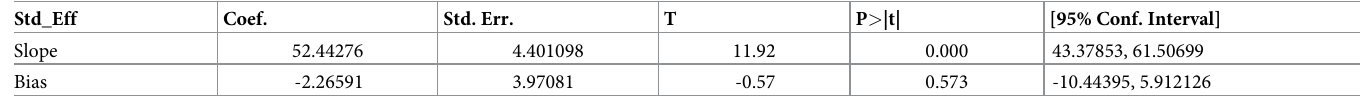
Table 3. Egger’stest of publication bias for the pooled WMD estimate of PC between PE and NT groups. Std_Eff Coef. Std. Err. T P > |t| [95% Conf. Interval]